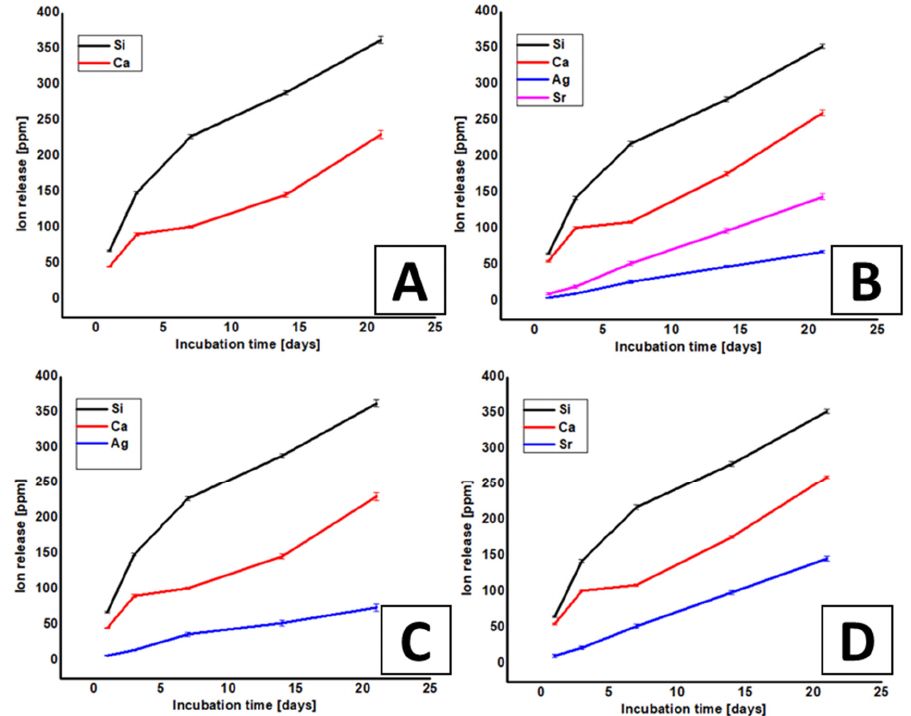
Figure 6. Absolute ion-release profile of Si, Ca, Sr, and Ag ions from ( A ) MBGMNs, ( B ) Ag-Sr MBGNs, ( C ) Ag MBGNs, and ( D ) Sr MBGNs samples immersed in SBF (Simulated Body Fluid) measured by using ICP (Inductively Coupled Plasma) shown in A to D (each experiment was repeated 5 times and the mean values were reported with the standard deviation represented by the error bars in the figure). The burst release of both ions (Ag, Sr) was observed from Ag-Sr MBGNs, which might be due to the concentration gradient between the particles and physiological solu- tion. Ag ions released in the physiological medium play an important role in the antibac- terial activity. The antibacterial properties (discussed in Section 2.5) of the synthesized